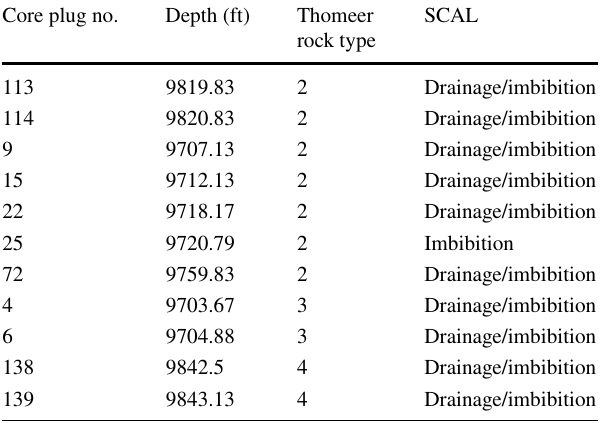
Table 2 Drainage/imbibition relative permeability curves used in